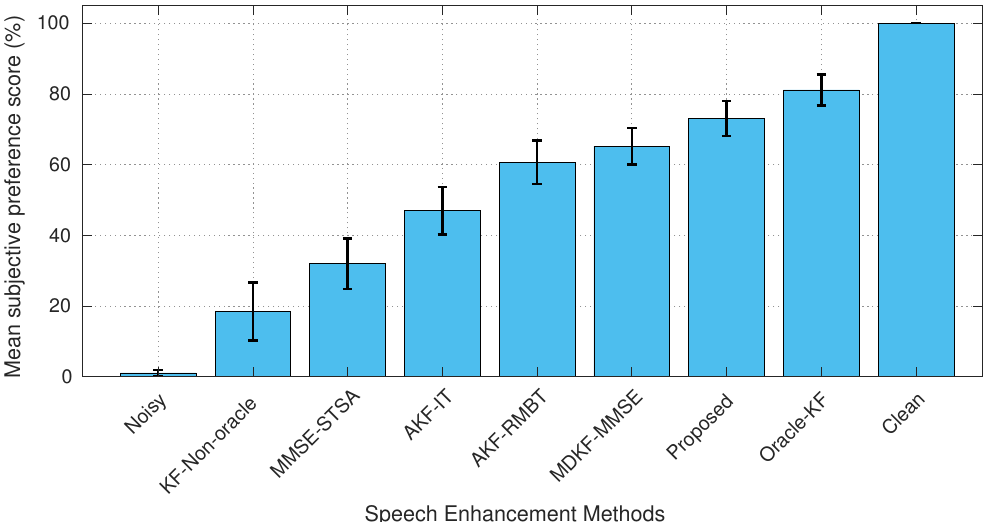
Figure 13. The mean preference score (%) comparison between the proposed and benchmark SEAs for the utterance sp05 corrupted with 5 dB non-stationary babble noise.